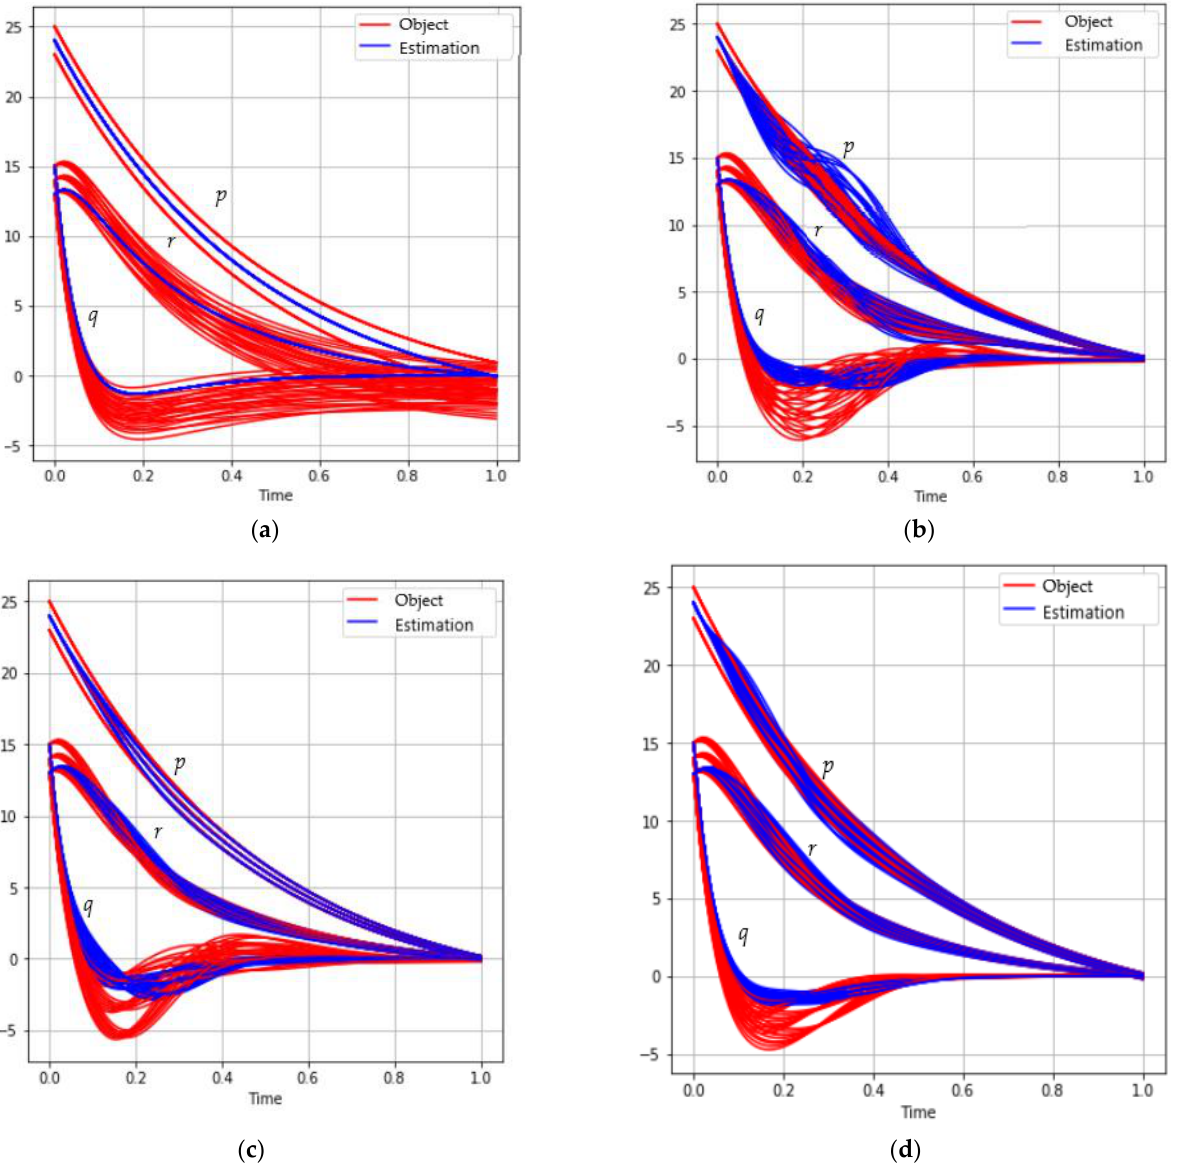
Figure 1. The behavior of the satellite coordinates p , q , r (red) and estimations (blue) for different mini-batch sizes: ( a ) d = 1; ( b ) d = 10; ( c ) d = 20; ( d ) d =